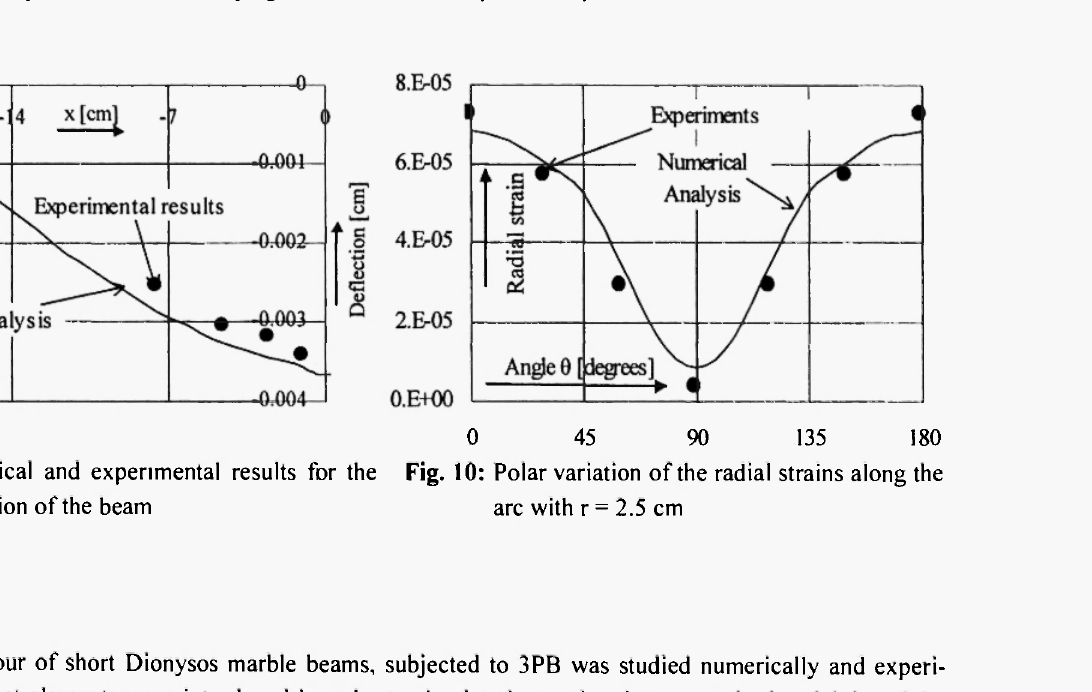
Fig. 9: Numerical and experimental results for the Fig. 10: Polar variation of the radial strains along the deflection of the beam arc with r = 2.5